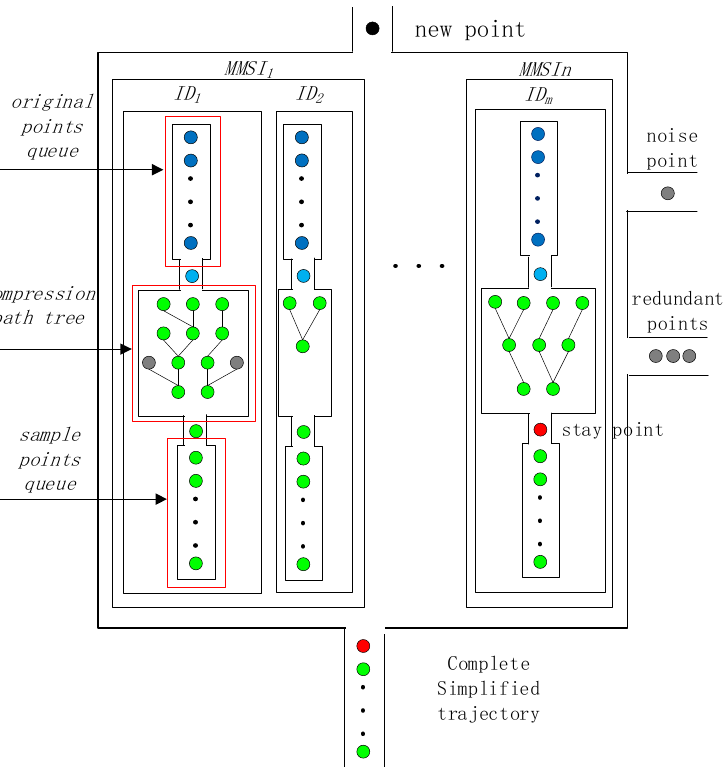
Figure 2. Trajectory preprocessing structure. MMSI is used as the unique identification code to exchange data. ID is used to identify a single trajectory. The original points queue is used to store the trajectory points, noise points are removed at this stage. The compression path tree is used to output the simplified trajectory, redundant points are removed at this stage. The sample points queue is used to store the simplified trajectory, when a stay point is detected, a complete simplified trajectory is output for clustering. The black circle represents a new received trajectory point. The dark blue circles represent the points ready to be cleaned. The green circles represent the sample points of the simplified trajectories. The gray circles represent noise points or redundant points. The red circles represent the stay points.